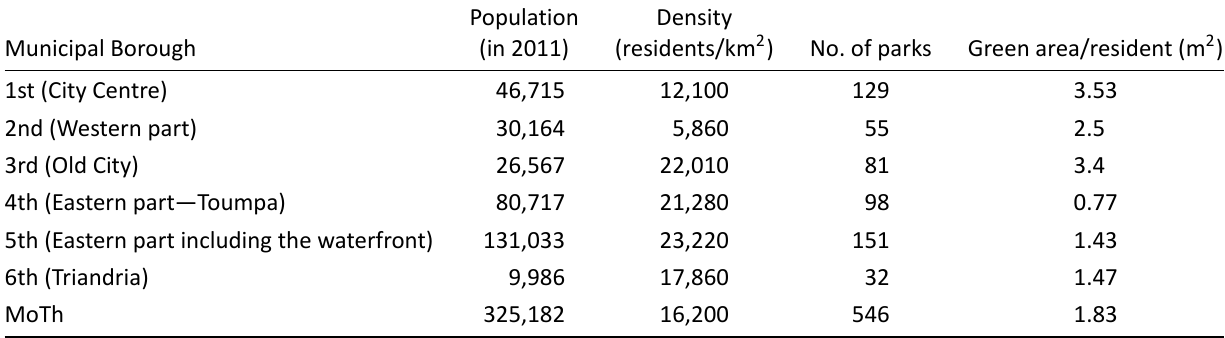
Table 2. Data on existing green public spaces in Thessaloniki.